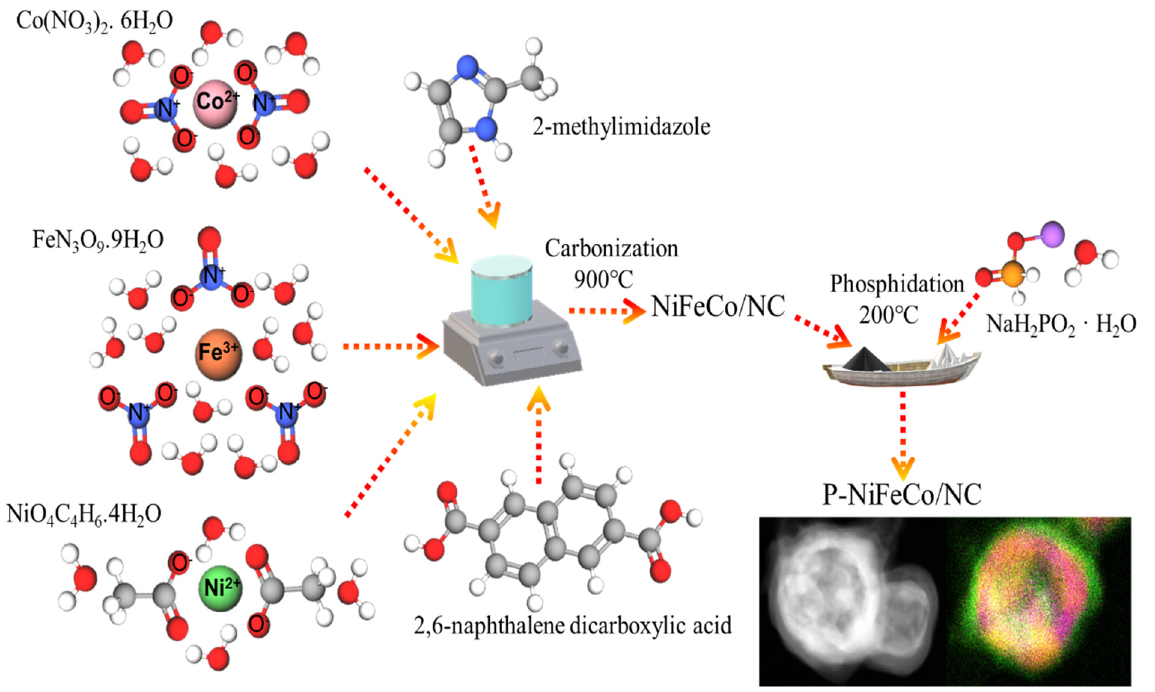
Figure 1. Synthesis procedure of the P-NiFeCo/NC catalyst.